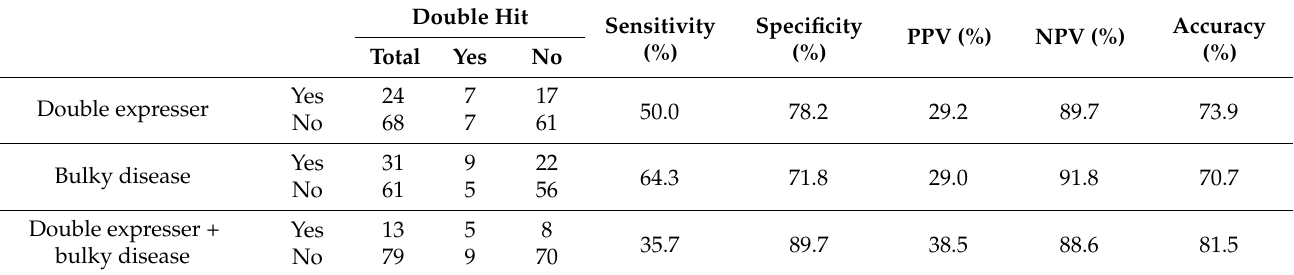
Table 4. Prediction of double hit